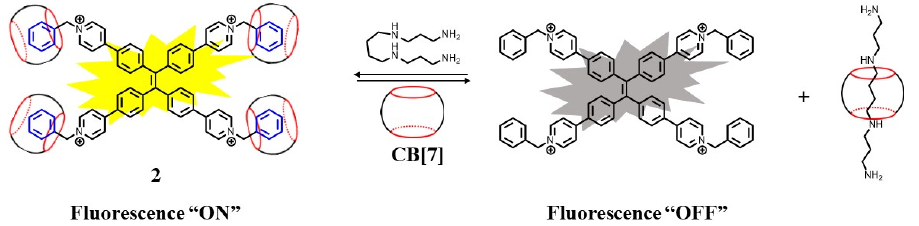
Figure 3. Proposed mechanism of the fluorescent probes for spermine and 1-adamantanamine, based on the supramolecular system formed between 2 and CB[7] [45].